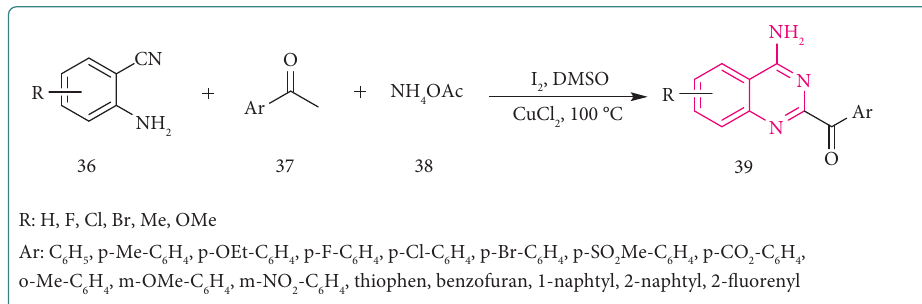
Scheme 6: Synthesis of 2-acyl-4-aminoquinazoline derivatives in the presence of I